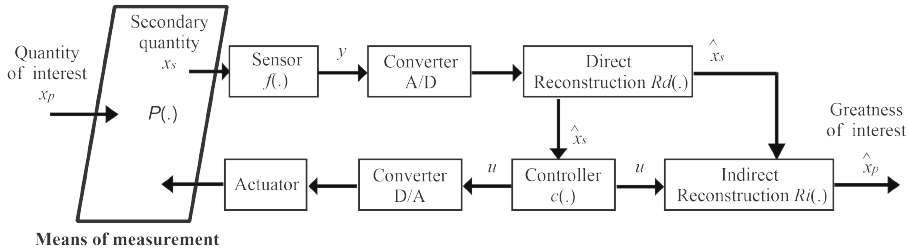
Figure 1. Generic diagram of a measurement feedback